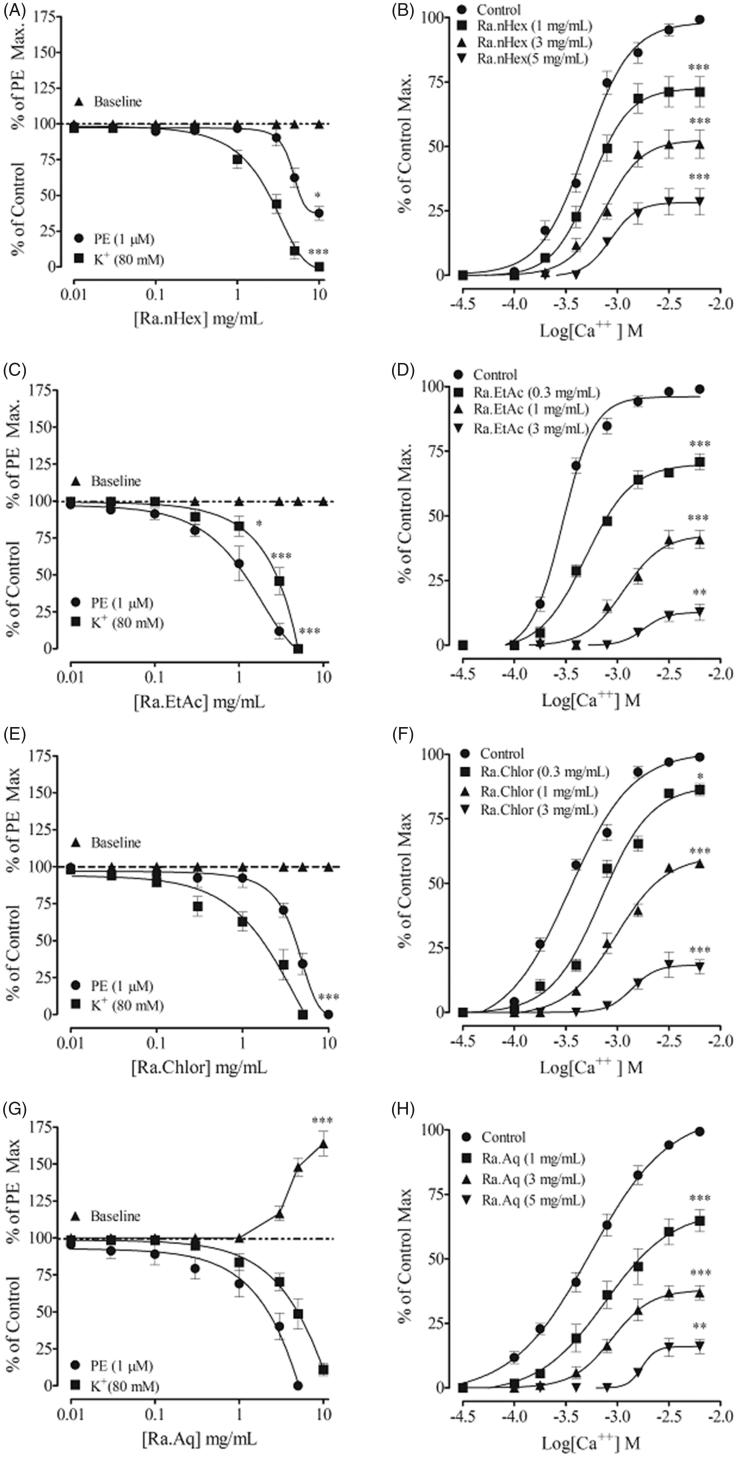
Concentration-dependent vasorelaxant response of all the fractions in rabbit aortic tissues and their respective sigmoidal CaCl2 curves constructed in Ca2+-free medium. Values shown are mean ± SEM. Five to six determinations.